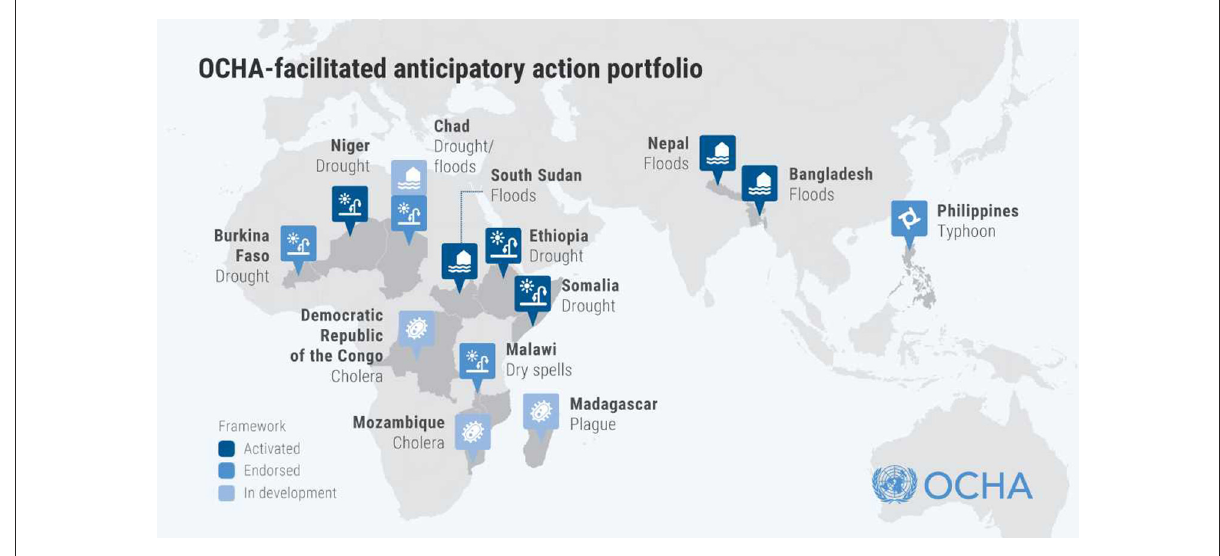
FIGURE1 OCHA-facilitated anticipatory action